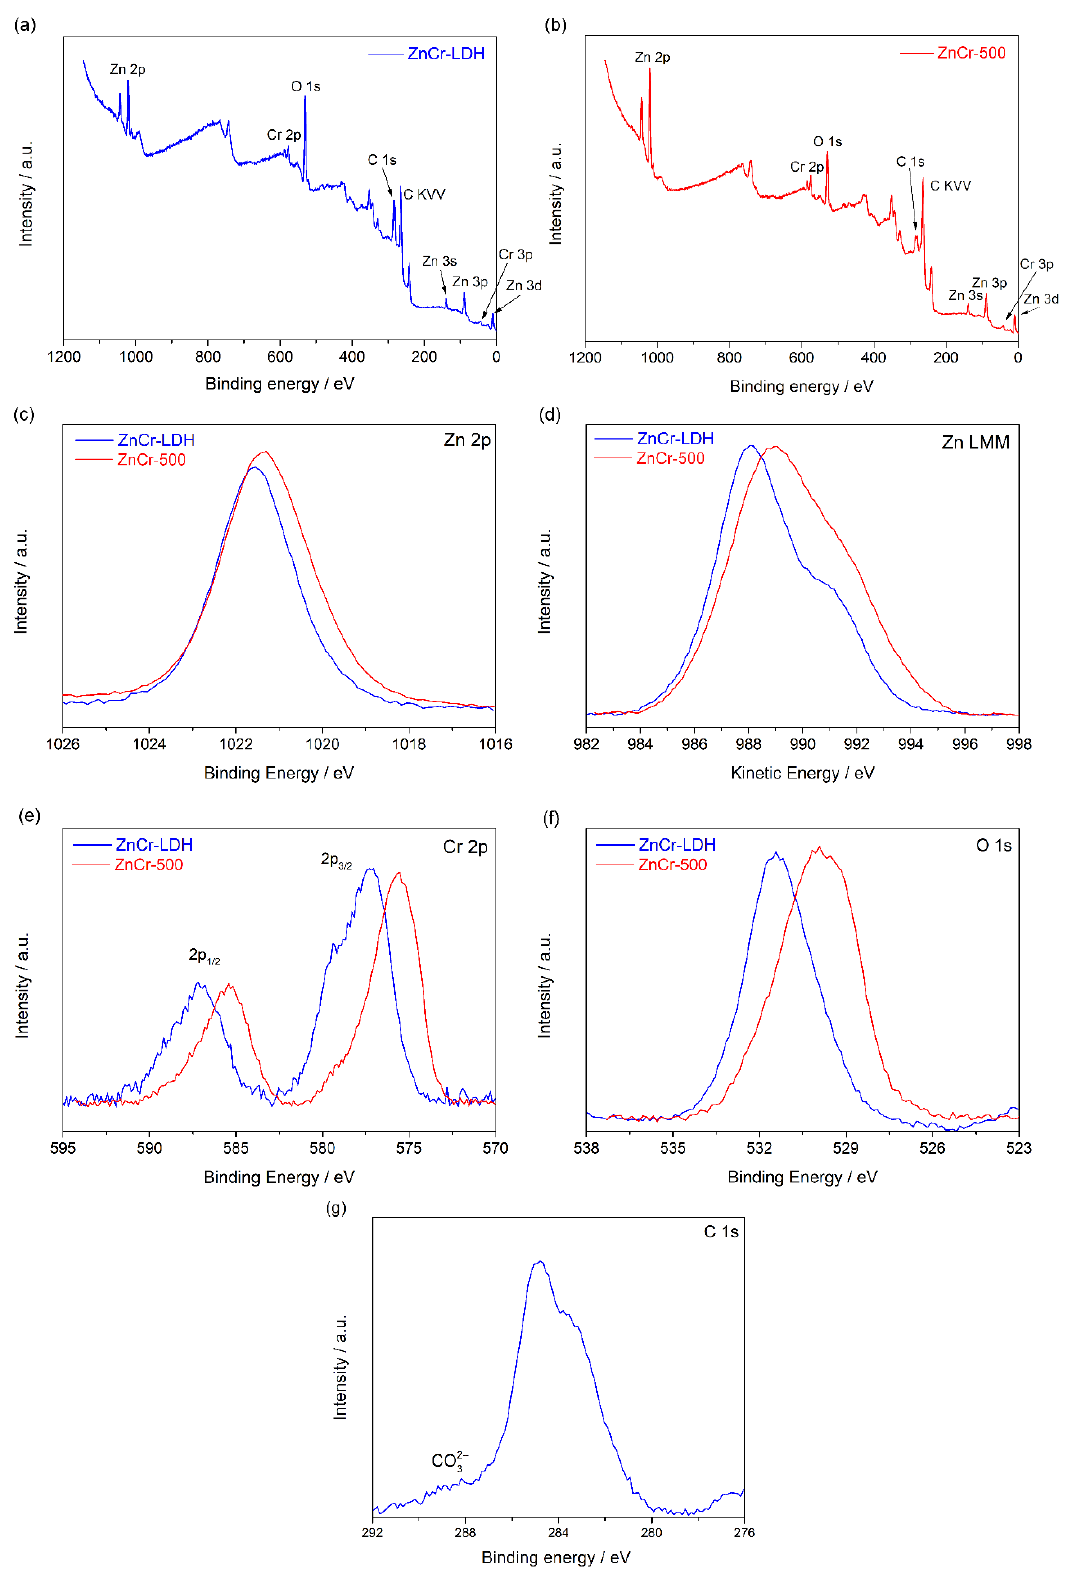
Figure 5. XPS measurements: survey spectra for ZnCr-LDH ( a ) and ZnCr-500 ( b ); Zn 2p region of both samples ( c ); Zn LMM Auger peak ( d ); and Cr 2p ( e ); O 1s ( f ) and C 1s ( g ) regions for both samples, and C 1s for ZnCr-LDH sample.